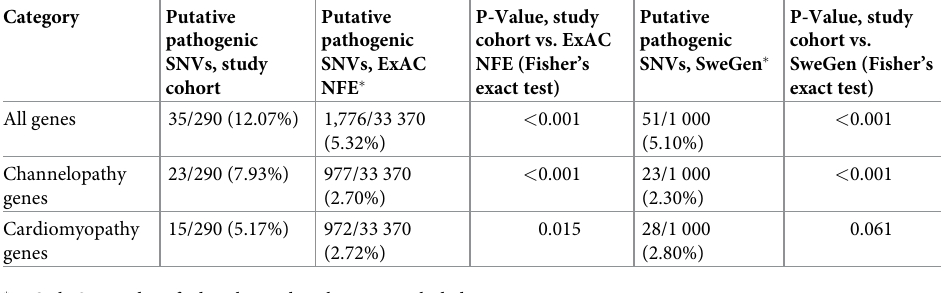
Table 3. Proportions of individuals with pathogenic SNVs in the study cohort, compared with the corresponding proportions of the same variants in ExAC NFE and SweGen.